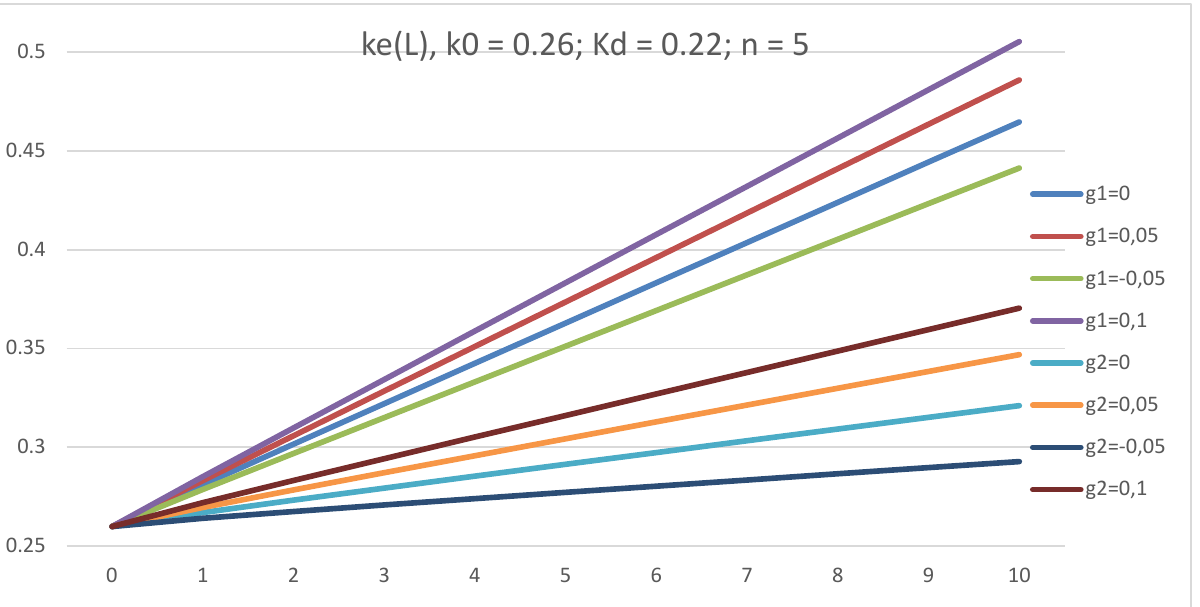
curves WACC(L) in the case of advance income tax payments lie below the curves in the case of income tax payments at the end of periods.